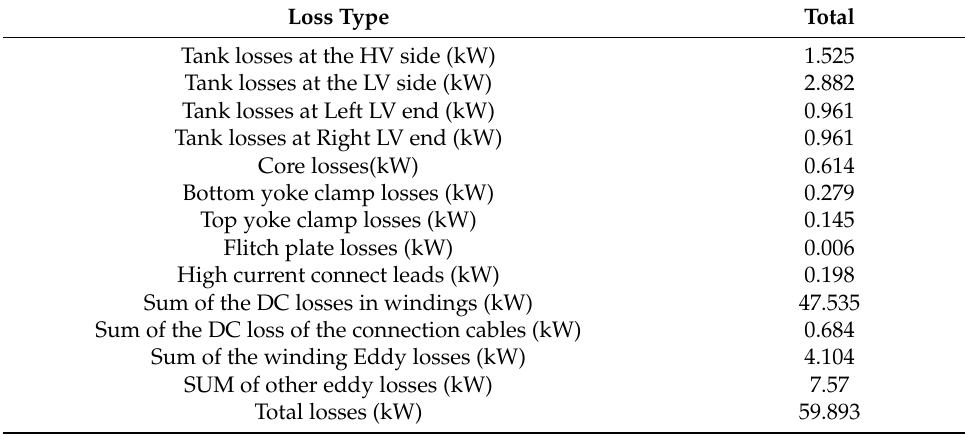
Table 6. Losses in metallic structures—Case 2.